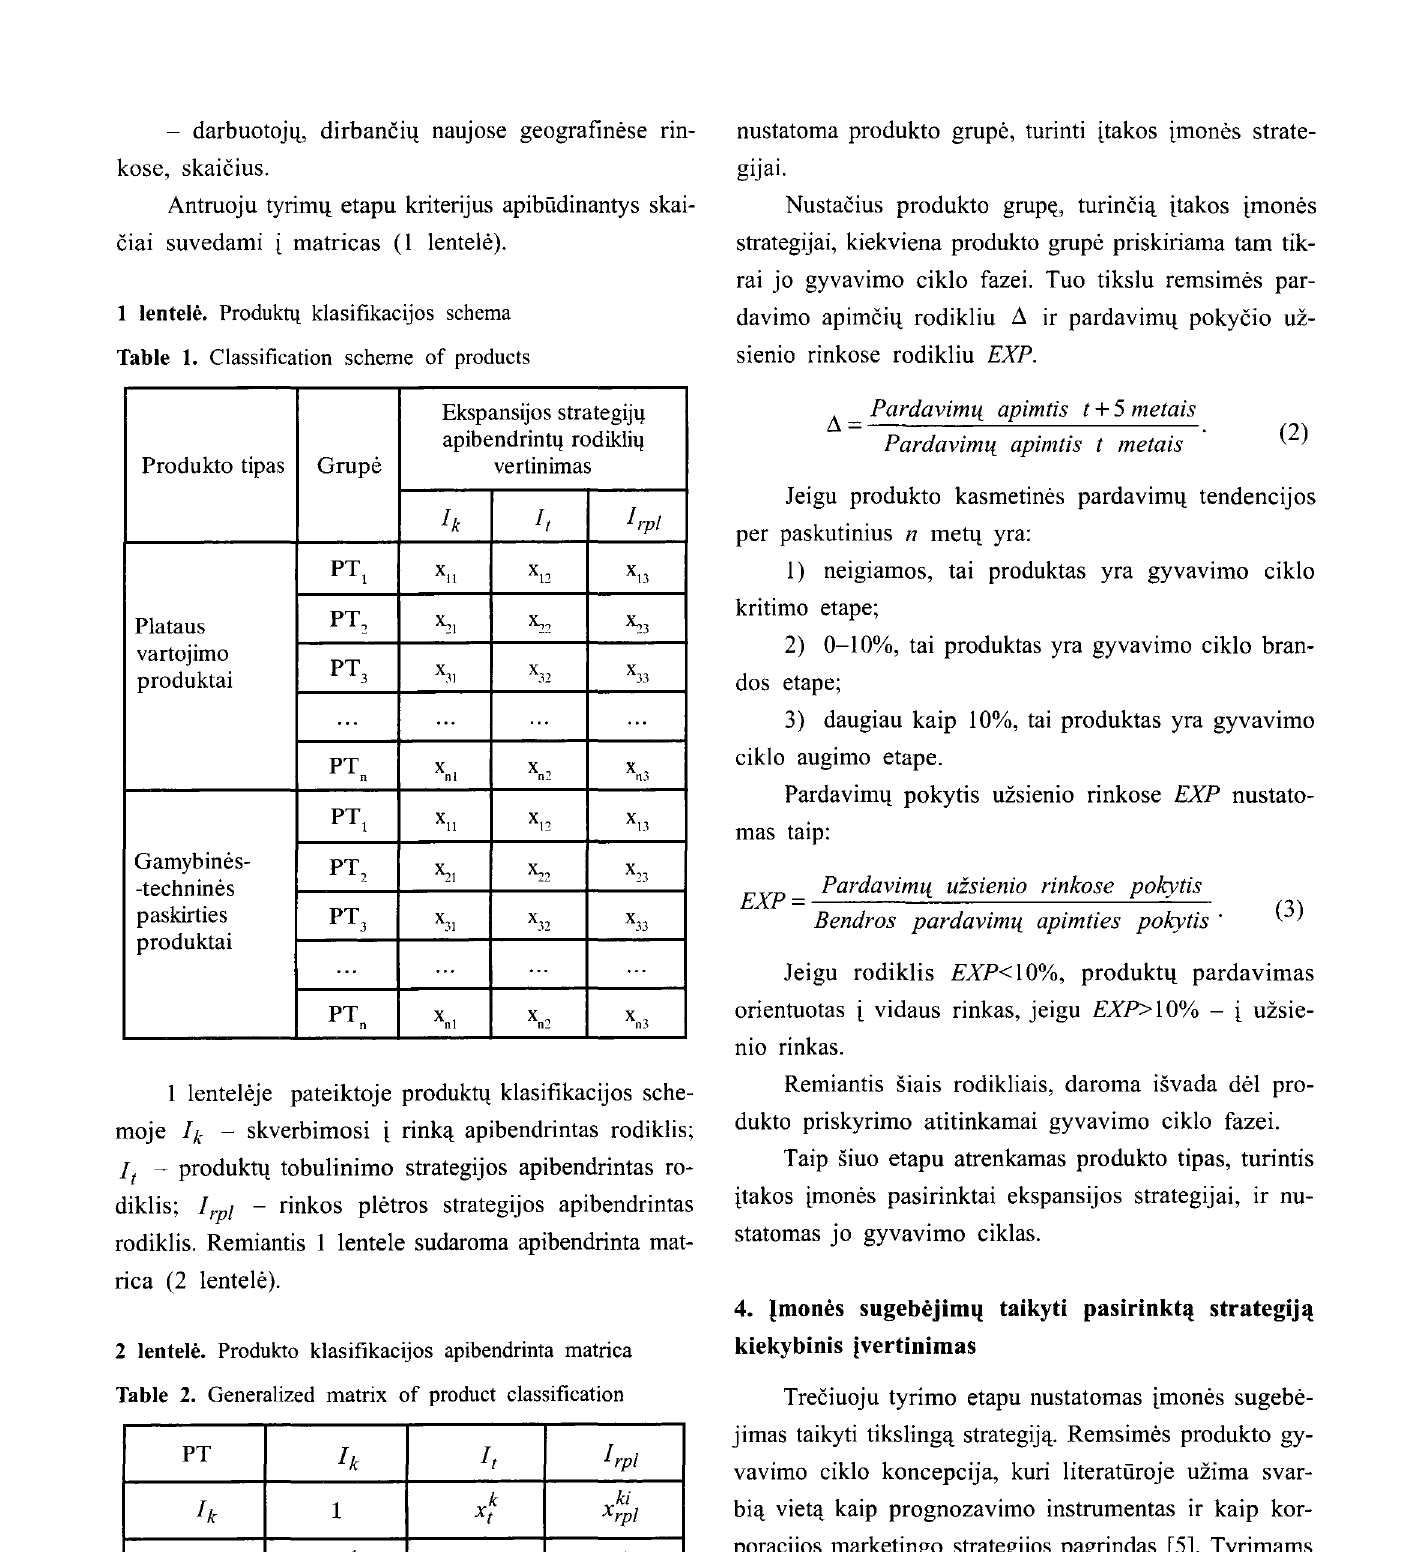
Table 1. Classification scheme of products